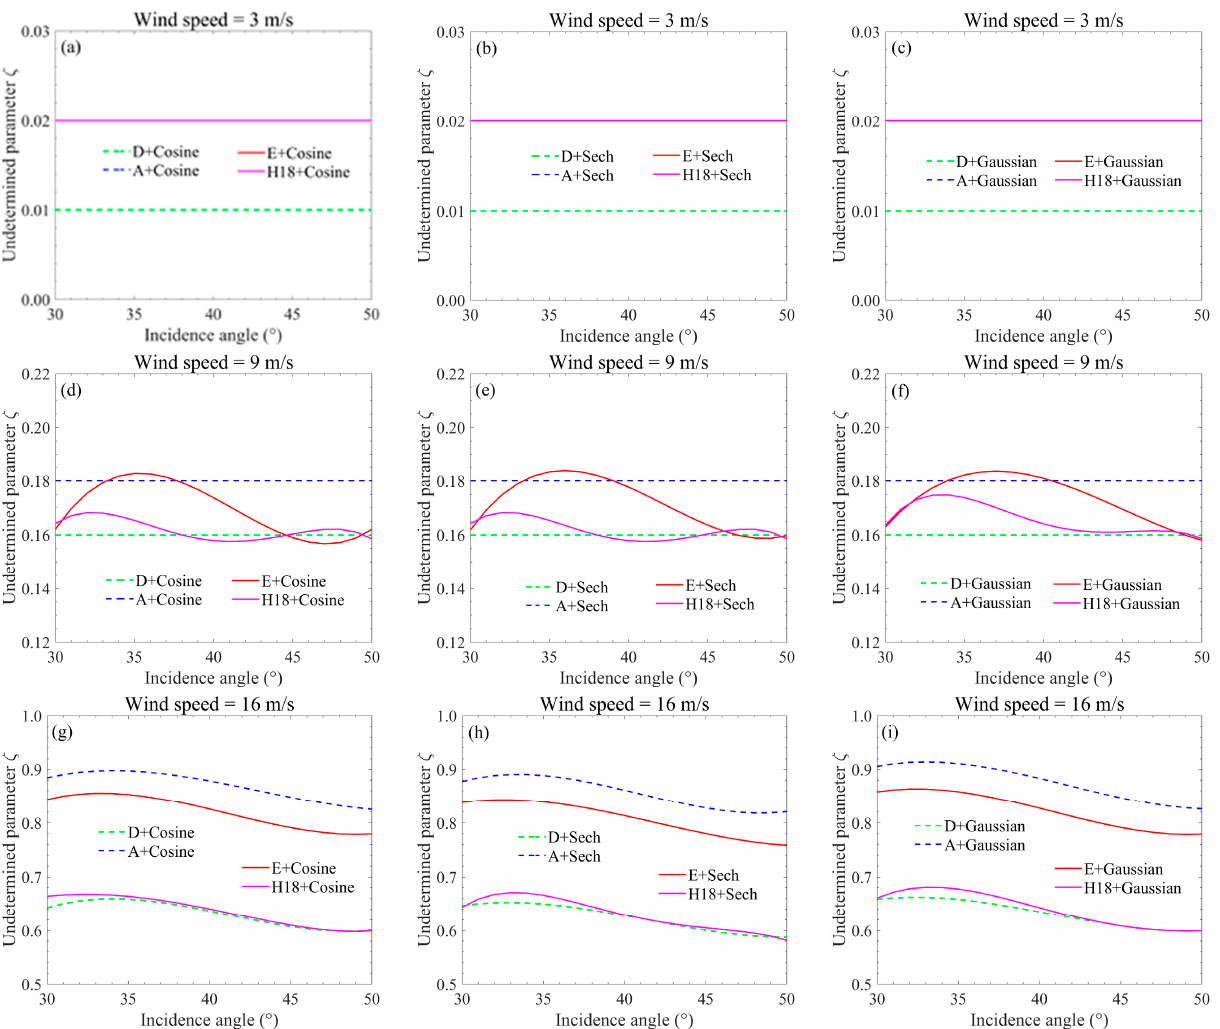
Figure 4. Estimations of the ζ parameter with the use of different directional wave spectra of D + Cosine, D + Sech, D + Gaussian, A + Cosine, A + Sech, A + Gaussian, E + Cosine, E + Sech, E + Gaussian, H18 + Cosine, H18 + Sech, and H18 + Gaussian as a function of incidence angle ( a – c ) at wind speed of 3 m/s, ( d – f ) at wind speed of 9 m/s, ( g – i ) at wind speed of 16 m/s. Figure 6 shows an example of comparison of the NRCSs predicted by the modified TSM (solid curves) and the conventional TSM (dashed curves) using different wave spectra and the Cosine spreading function, and their comparisons with CMOD5.n at a wind speed of 16 m/s and an incidence angle of 50 ◦ . As can be seen, whichever wave spectrum is used, the modified TSM can well simulate the upwind–downwind asymmetry, which cannot be described by the conventional TSM. It achieves this by introducing a negative correction in the downwind direction (180 ◦ ) and a positive correction in the upwind direction (0 ◦ ) using the additional bispectral term. Moreover, the minimum of the modified-TSM-simulated NRCS deviates from the crosswind direction (90 ◦ /270 ◦ ) and moves to the downwind direction. All these changes diminish the gap between the predictions of model and CMOD5.n